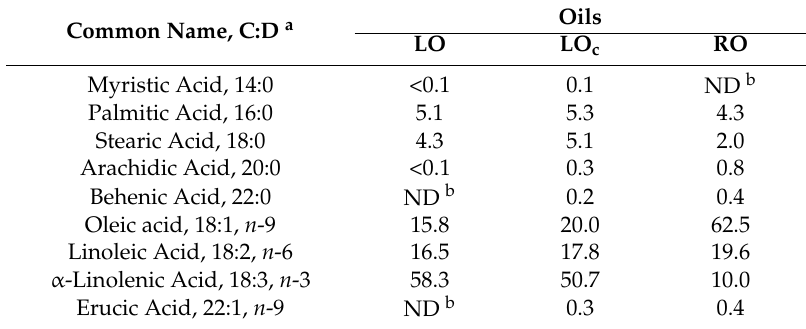
Table 2. Fatty acid (FA) composition of the three oils used: quantitative analysis of identified fatty